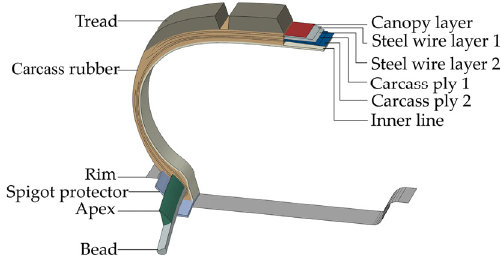
Figure 1. Schematic diagram of tire model structure.